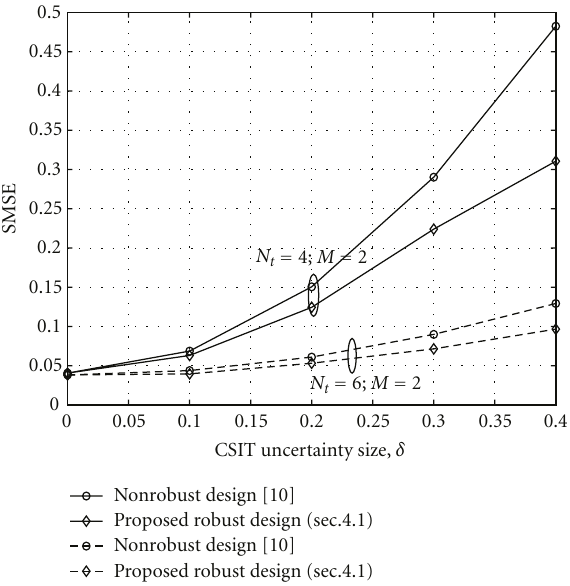
Figure 3: SMSE versus CSIT error variance ( σ 2 E ) performance of Figure 4: SMSE versus CSIT uncertainty size ( δ ) performance of the proposed robust design in Section 3 for the SE model. N t = 6,8, the proposed robust design in Section 4.1 for the NBE model. N t = N N L M = 3, N = L = L = 2, P = 15 dB, σ 2 = r 1 = r 2 = r 3 = 2, n 1 2 3 max = N r = N r = 2, L = L = L = 2, δ = δ = δ , 6,4, M = 2, N r 1 2 3 1 2 1. Larger the value of σ 2 , higher is the performance improvement 1 2 3 P E = 15 dB, σ 2 = 0 . 1. Proposed robust design in Section 4.1 n max due to the proposed design in Section 3 compared to the nonrobust performs better than the design in [10]. design in [10].